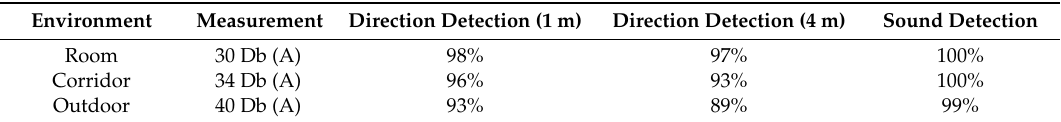
Table 2. Success rate of different environment.